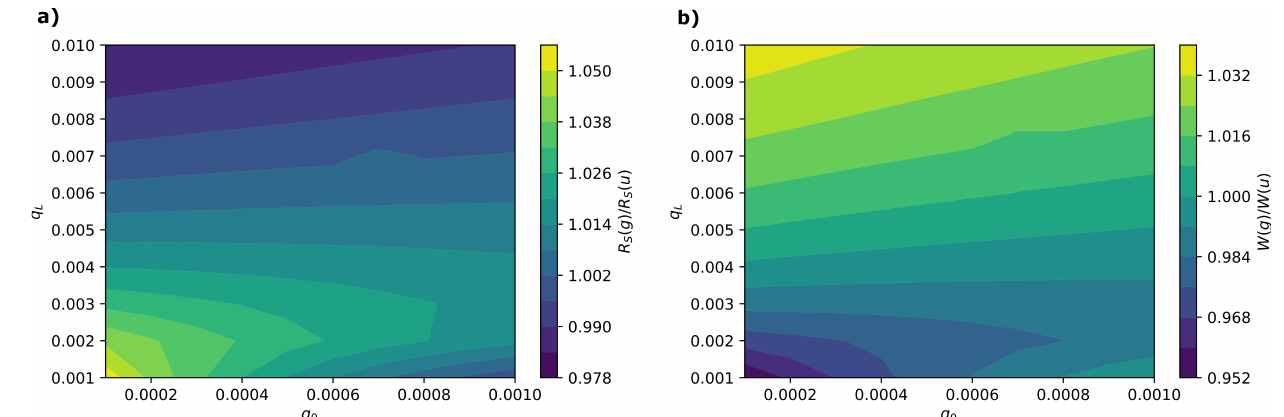
Figure 2. Ratio of separation parameters of gradient and uniform columns as the function of q 0 and q L for linear capacity gradient. ( a ) Ratio of gradient and uniform column resolutions, ( b ) Ratio of bandwidths calculated for gradient and uniform columns for mono2.